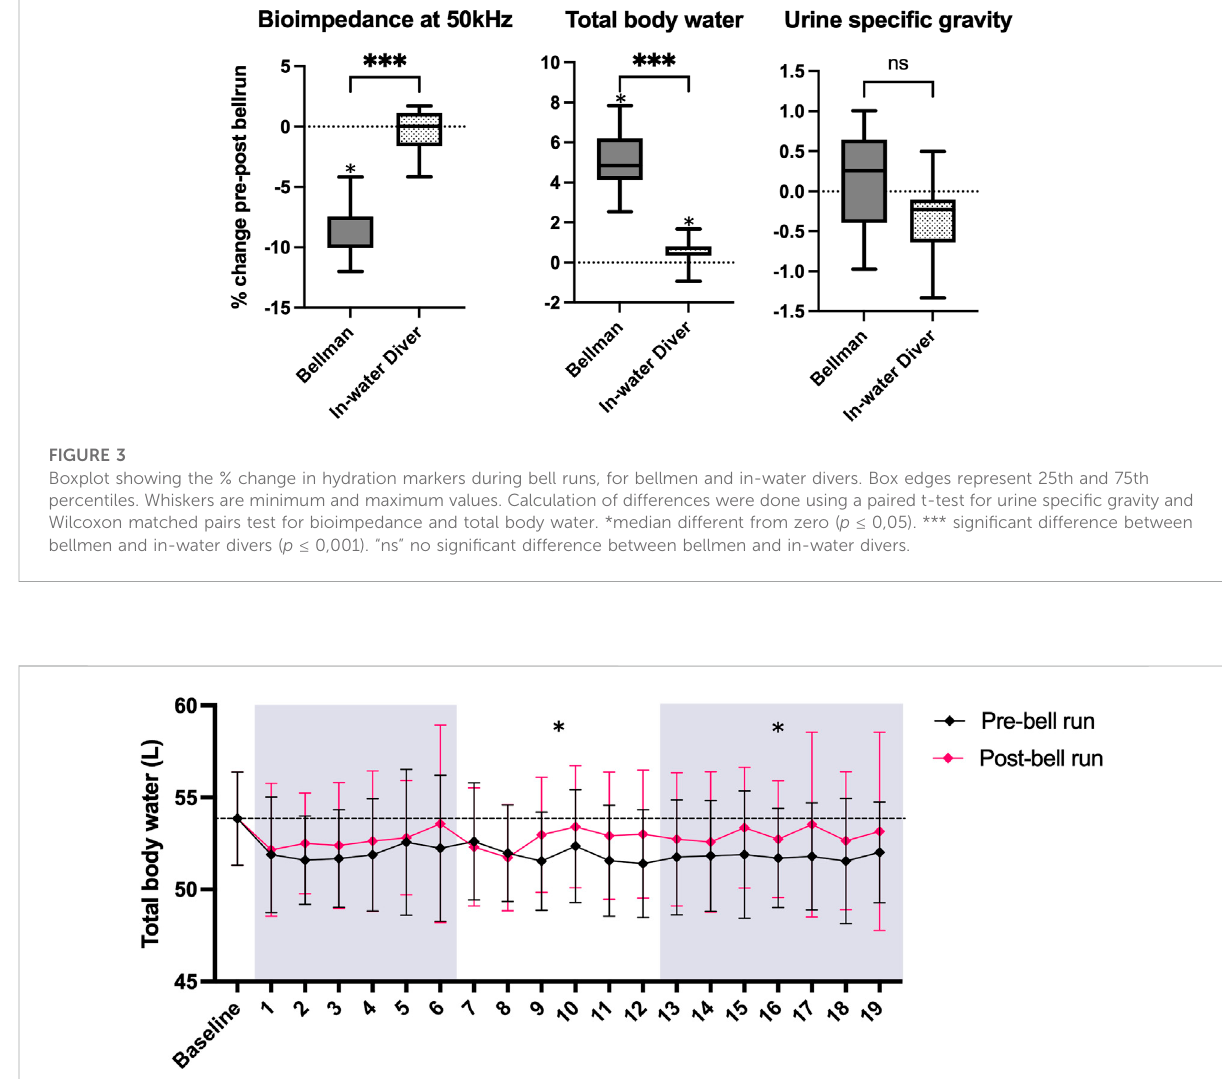
signi fi cant increase also for the in-water divers: the Wilcoxon matched pairs test showed that the bellmen had a median change in total body water of 4.8 percent, whereas the in-water divers had a median change of 0.7 percent, giving a median of differences of 4.1 ( p = 0.001). There were no changes in USG after bell runs. Results of single bell run comparisons are shown in Figure 3.